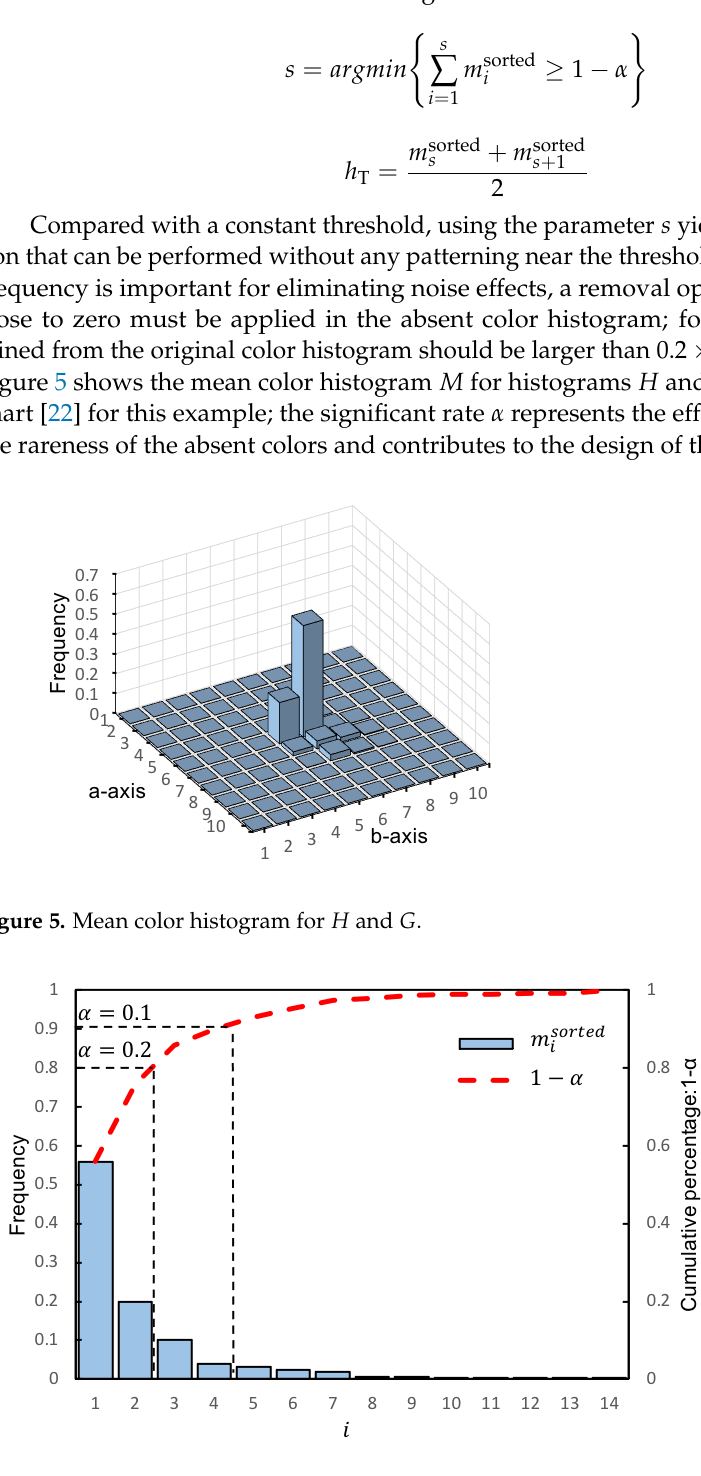
Figure 6. Parameter α and sorted one-dimensional histogram in Pareto